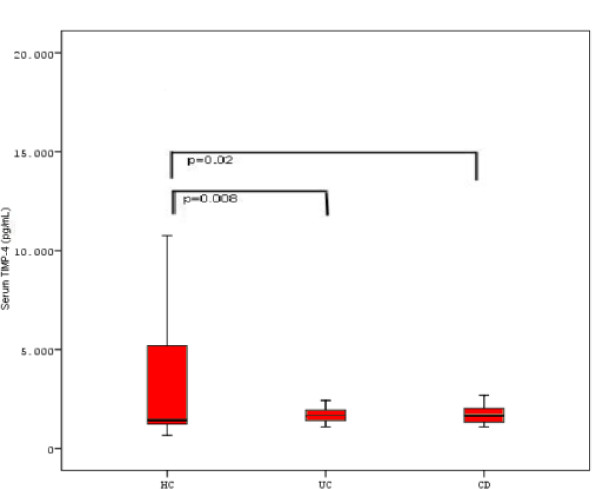
Bar graph showing TIMP-4 levels in UC, CD patients and HC and the statistical significance of mean differences.